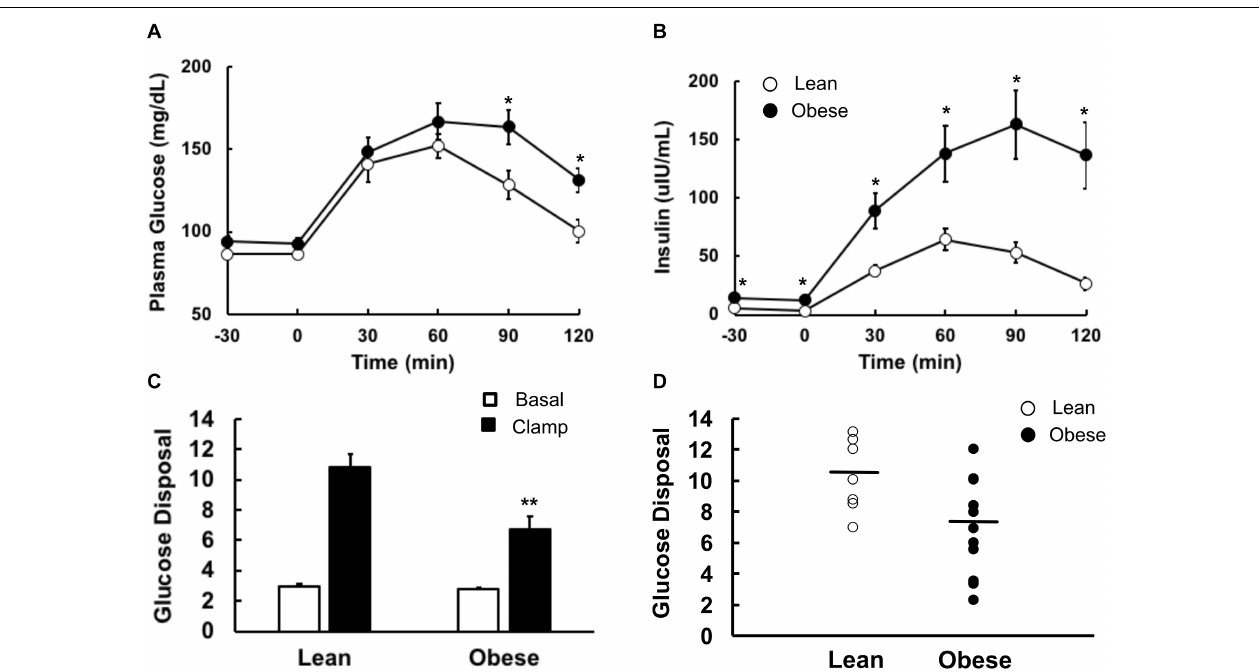
FIGURE 3 | Glucose metabolism in lean and obese volunteers. All studies were done after an overnight fast, on separate days. (A) Plasma glucose and (B) plasma insulin concentrations during a 2-h 75 g oral glucose tolerance test. Lean participants are shown as open circles, obese as closed circles. (C) Basal (open bars) and